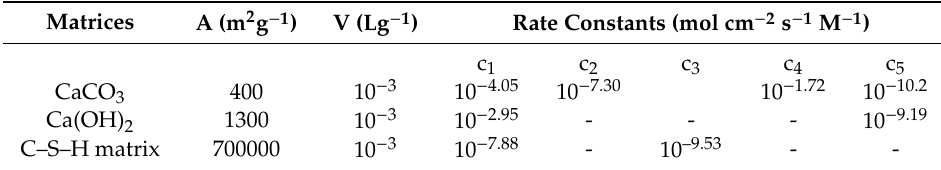
Table 4. Dissolution rate constants of the matrix in the solidified product [23].